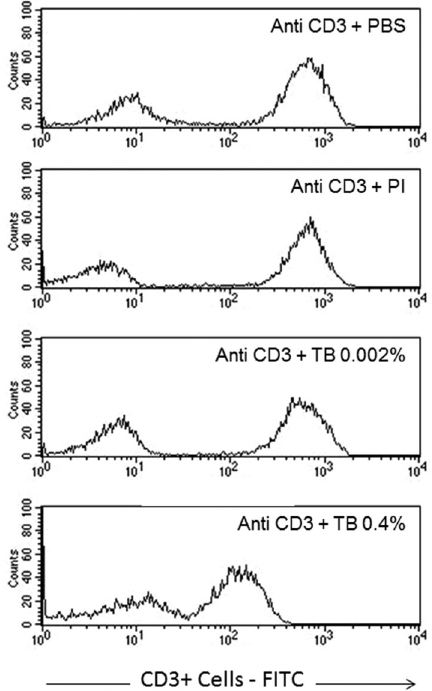
Figure 6. Profile of T-lymphocytes stained with monoclonal antibody anti-CD3-FITC followed by treatment with propidium iodide (PI) and trypan blue (TB) at 0.002 and 0.4% (w/v) or PBS (untreated